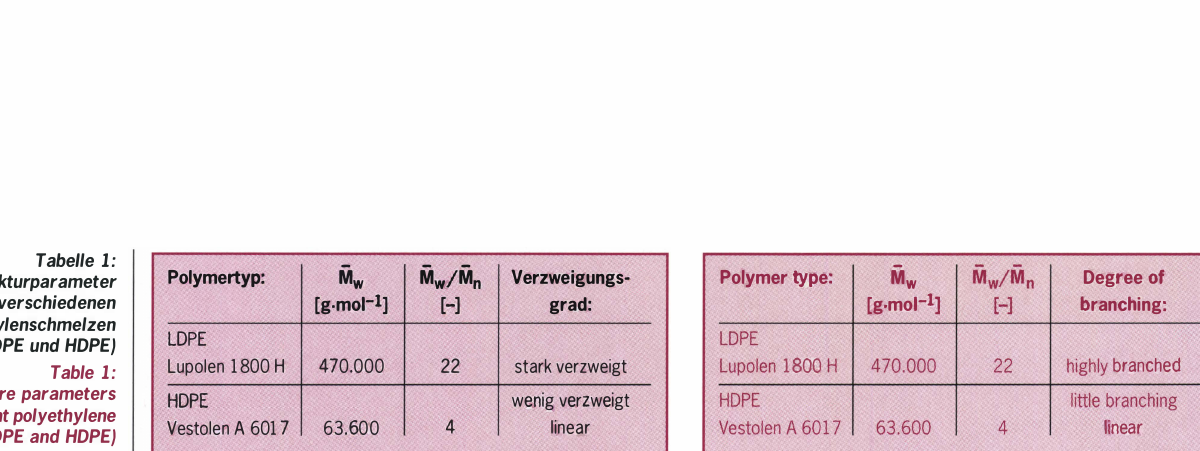
Tabe/le 1: Molekulare Strukturparameter von zwei verschiedenen Polyethylenschmelzen (LOPE und HOPE} Table 1: Molecular structure parameters of two different polyethylene melts (LOPE and